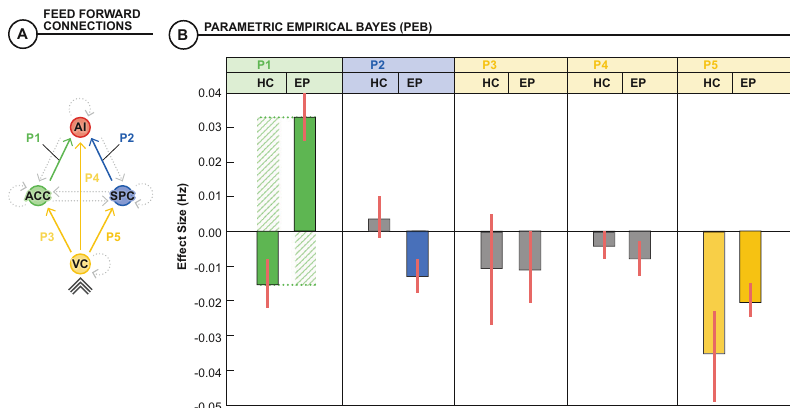
Fig. 4 Individual differences in effective connectivity and structural connectivity. A PEB was used to model the effect of all trials on effective connectivity on the feedforward connections common to all models and participants (as derived from the DCM) and its covariance with navigability distance of the network ’ s input-output (i.e., VC to AI) using a random-effects analysis. B For healthy controls, higher average effective connectivity was associated with shorter network navigability distance in the ACC to AI and VC to SPC connections. For EP participants, higher connectivity was associated with longer network navigability distance in the ACC to AI connection and shorter navigability network distance in the SPC to AI and VC to SPC connections. Note that there are opposing patterns of structural-functional coupling in the ACC to AI connection between groups, which compromises the cingulo-opercular network of the